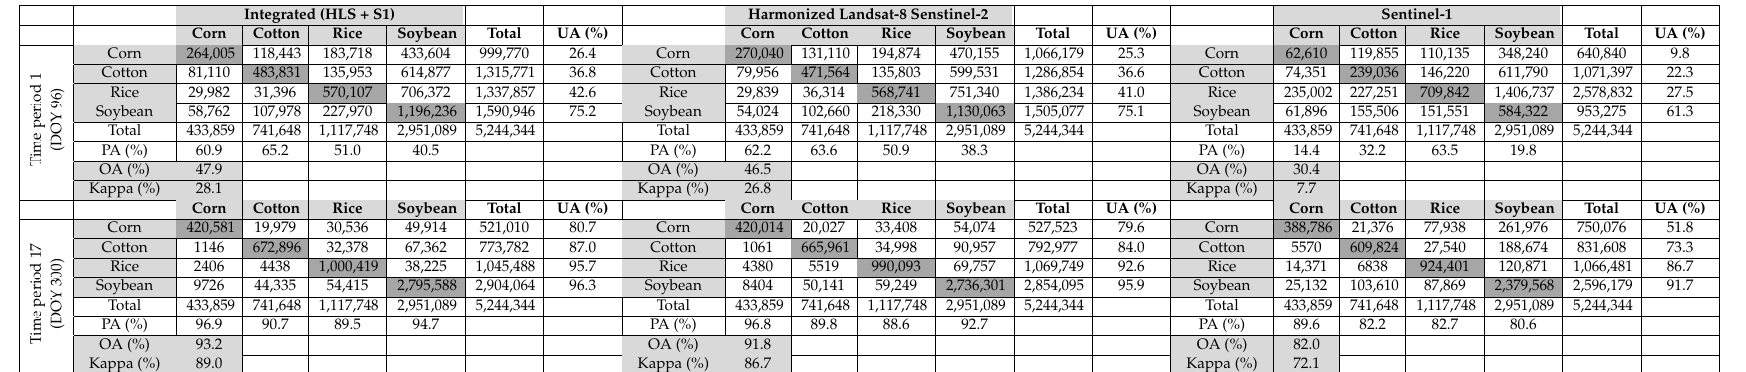
Table 3. An example error matrix for one classification scheme in northeast Arkansas (NEA) by sensor combinations at Day Of Year 96 and 300 highlighting shifts in